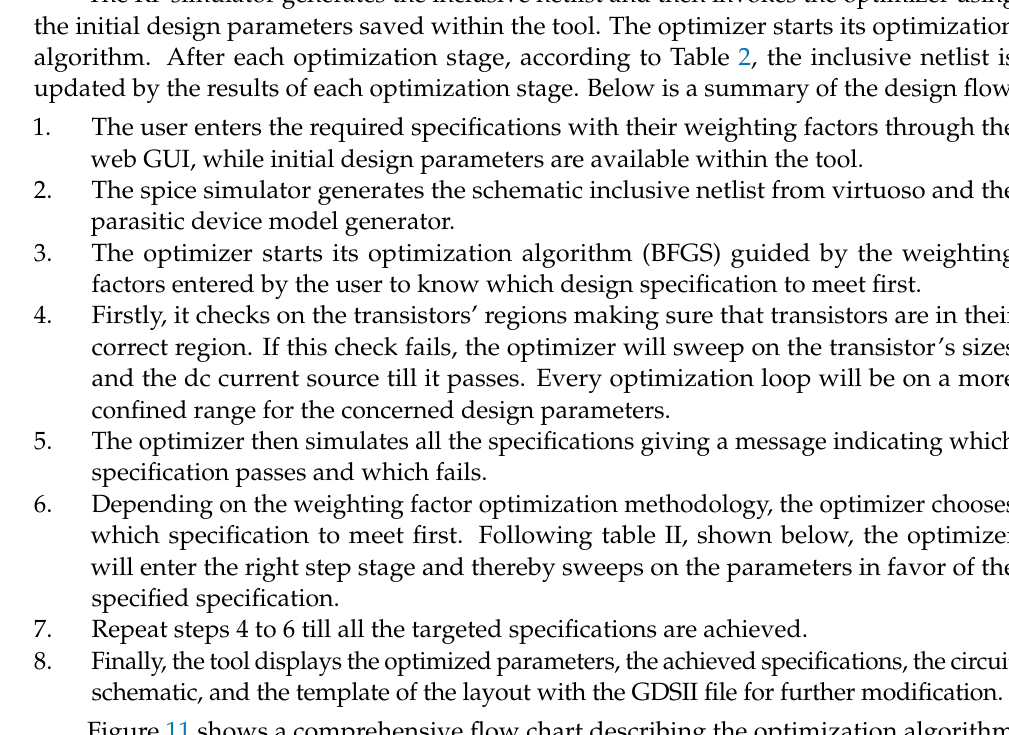
F.B. RC network elements (Rcas and Ccas) and the inductor of the output matching network (L o1